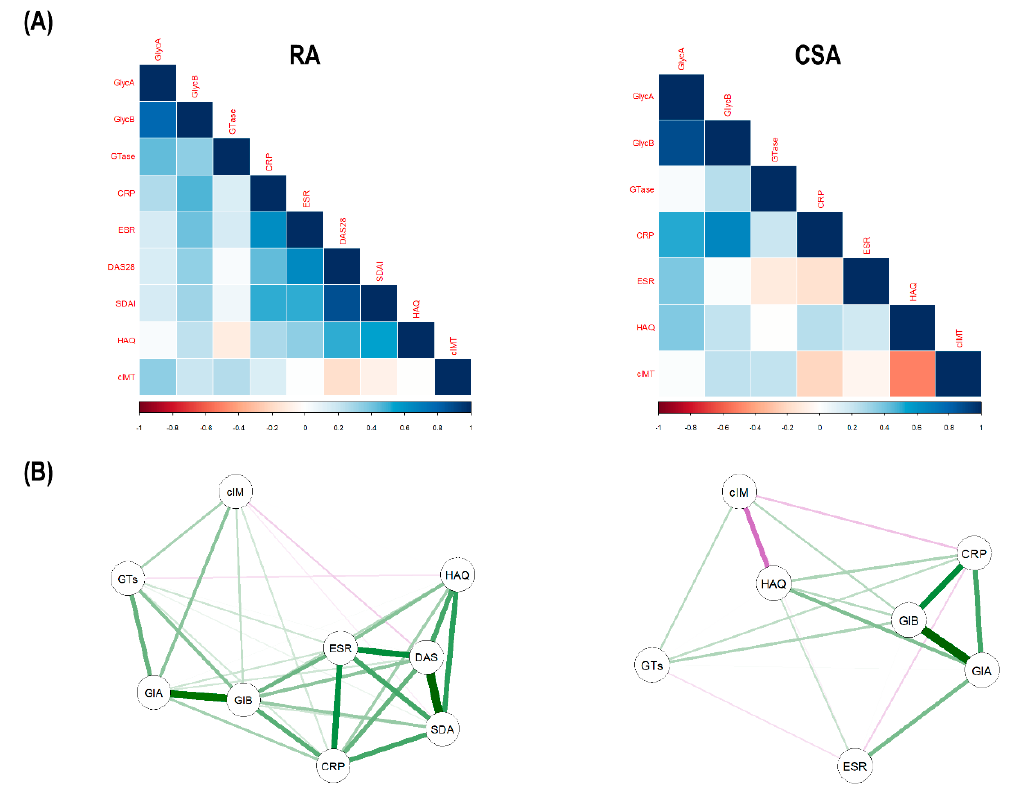
Figure 5. Integrative analyses of glycoprotein profiles, glycosyltransferase activity, and inflammatory markers. ( A ) The correlations among glycoprotein levels (GlycA and GlycB), glycosyltransfersase activity (GTase), inflammatory parameters (CRP and ESR), disease indices (DAS28, Simplified Disease Activity Index (SDAI), and Health Assessment Questionnaire (HAQ)) and carotid intima-media thickness (cIMT) were plotted in correlation matrices. In these correlograms, the colour of the tiles is proportional to the strength of the correlation between each pair of variables, according to the legend at the bottom. Names of the variables are indicated in red. ( B ) Network analyses depicted based on the correlations among variables. Each node corresponds to a variable (GlA: GlycA, GlB: GlycB, GTs: GTase, cIM: cIMT, DAS: DAS28, SDA: SDAI) and the lines between nodes illustrate the strength (width) and type (green: positive, red: negative) of the correlations between each pair of nodes. The relative position of the nodes parallels its degree of correlation, that is, nodes more closely correlated locate closer to each other.